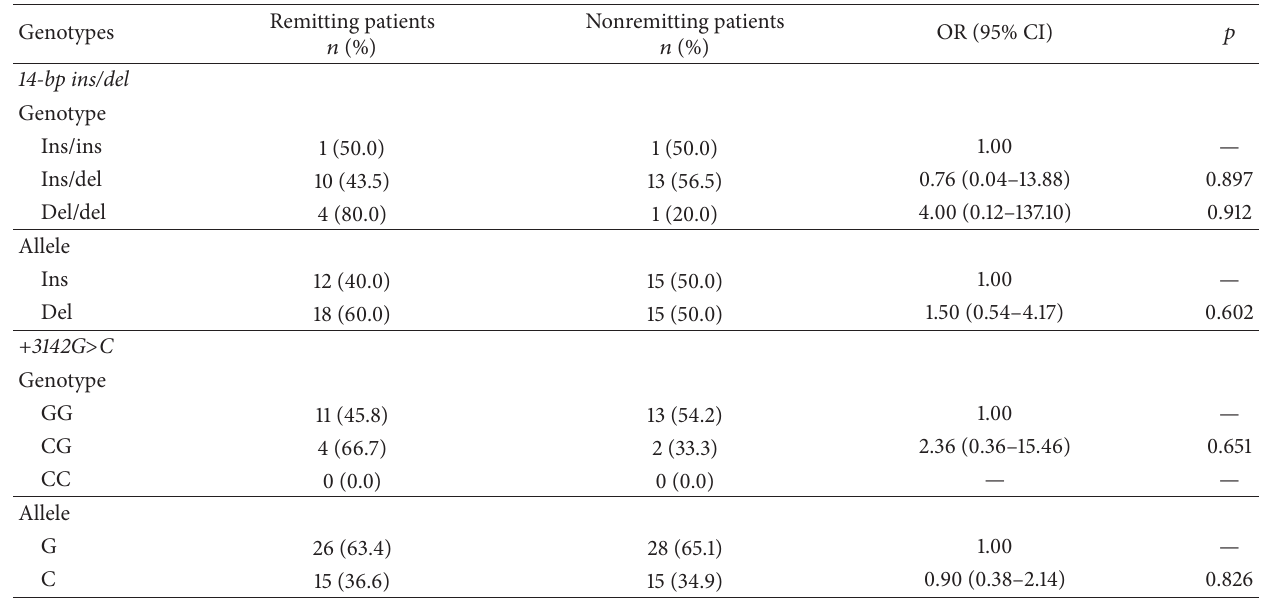
Table 5: Association of HLA-G polymorphism in remitting and nonremitting RA patients.